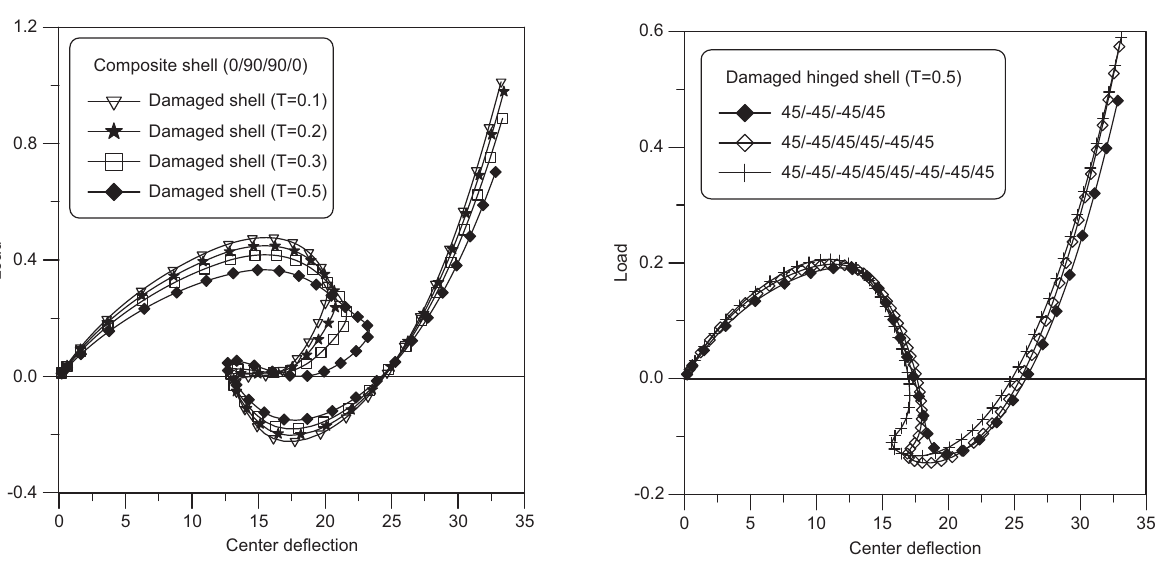
Figure 22 Load-displacement curves of hinged cylindrical shell.